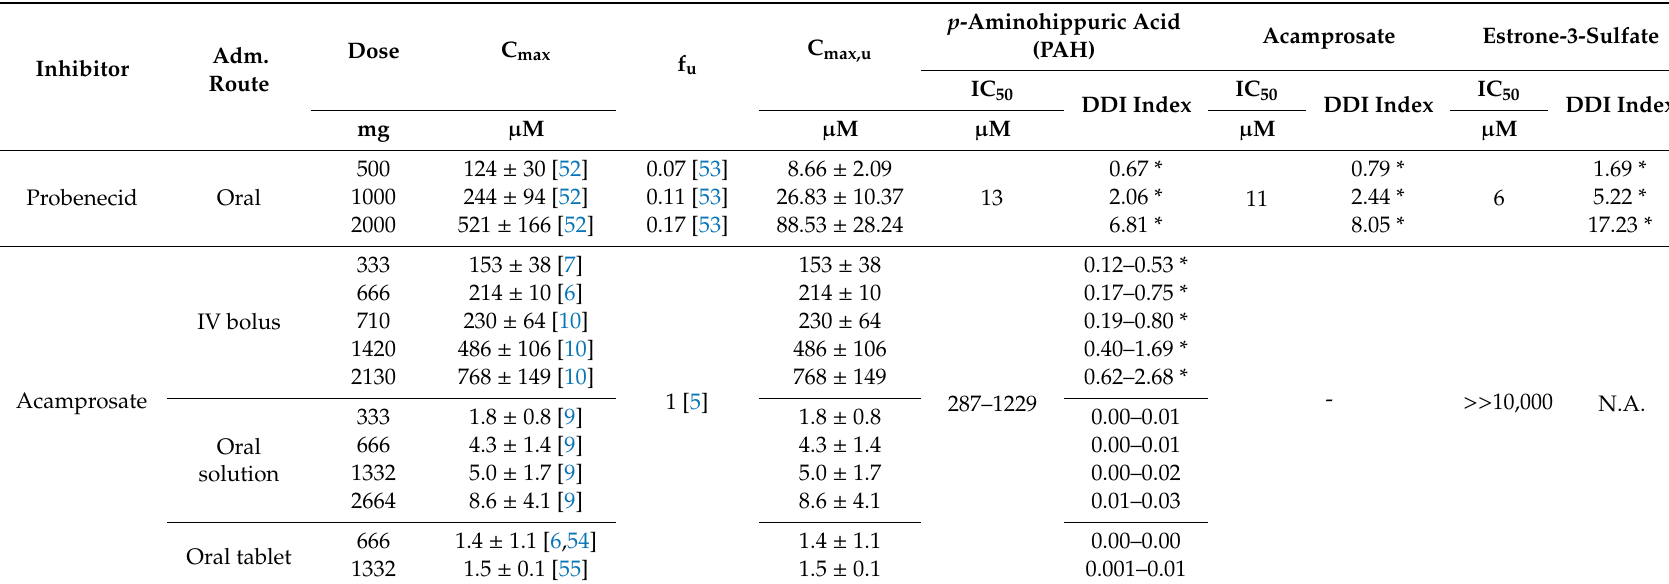
Table A1. Maximal mean ( ± SD) plasma concentration (C max ), fraction unbound in plasma (f u ), and in vitro obtained IC 50 values together with the calculated unbound maximal plasma concentration (C max,u ) and DDI indexes for probenecid–PAH, probenecid–acamprosate, probenecid–E3S and acamprosate–PAH interactions. N.A. not